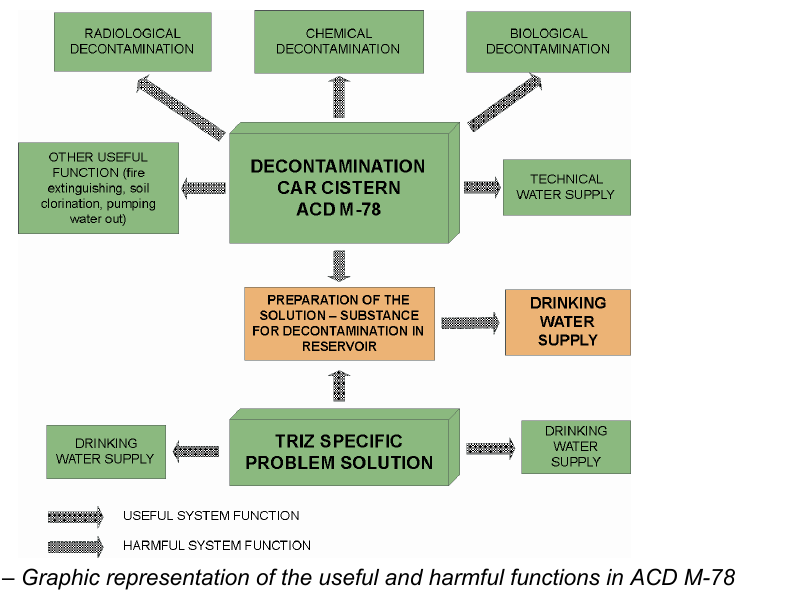
Figure 2 – Graphic representation of the useful and harmful functions in ACD M-78 Рис . 2 – Изображение полезных и вредных функций АЦД М -78 Слика 2 – Графички приказ корисних и штетних функција АЦД М